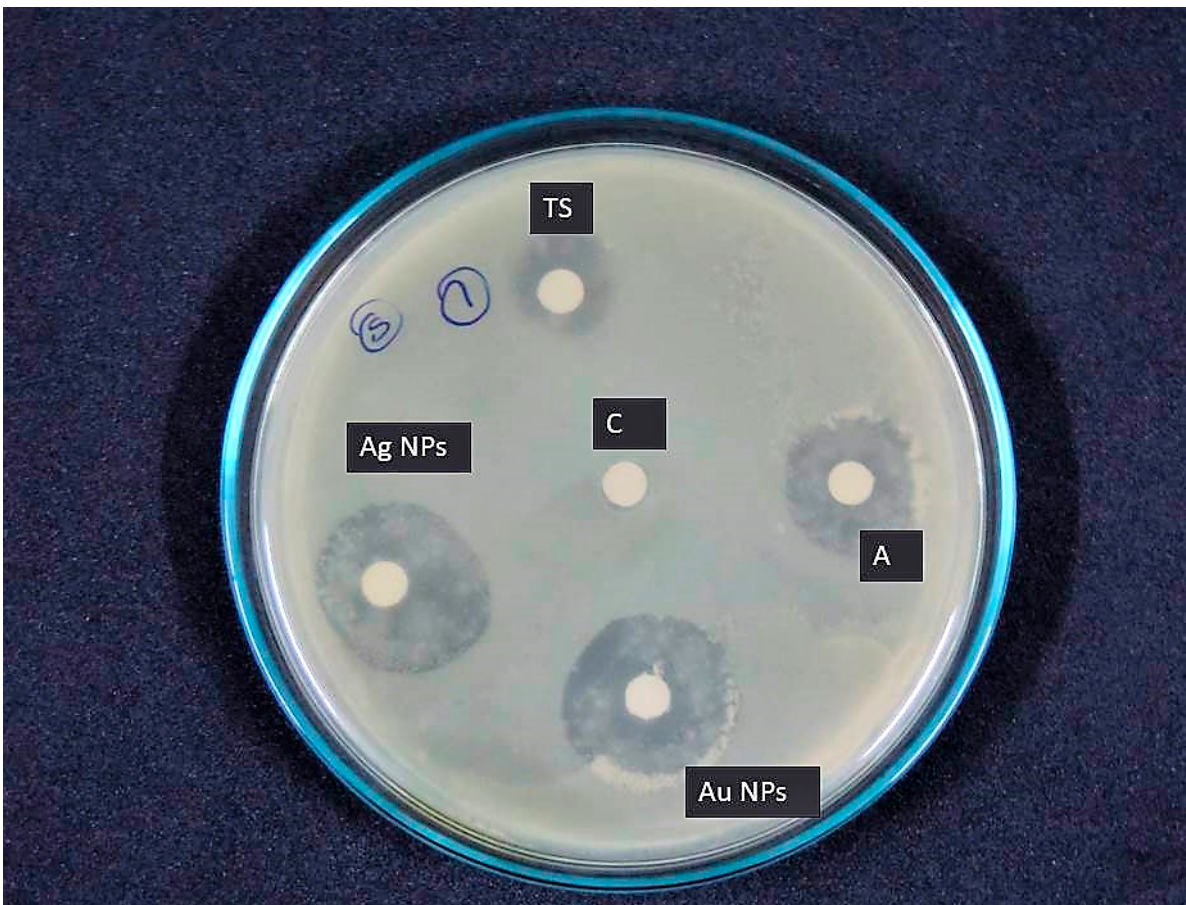
Figure 10. In vitro antibacterial activity of silver and gold nanoparticles synthesized from mangrove-derived strain Thraustochytrium kinnei TSKK1 against Klebsiella pneumonia.